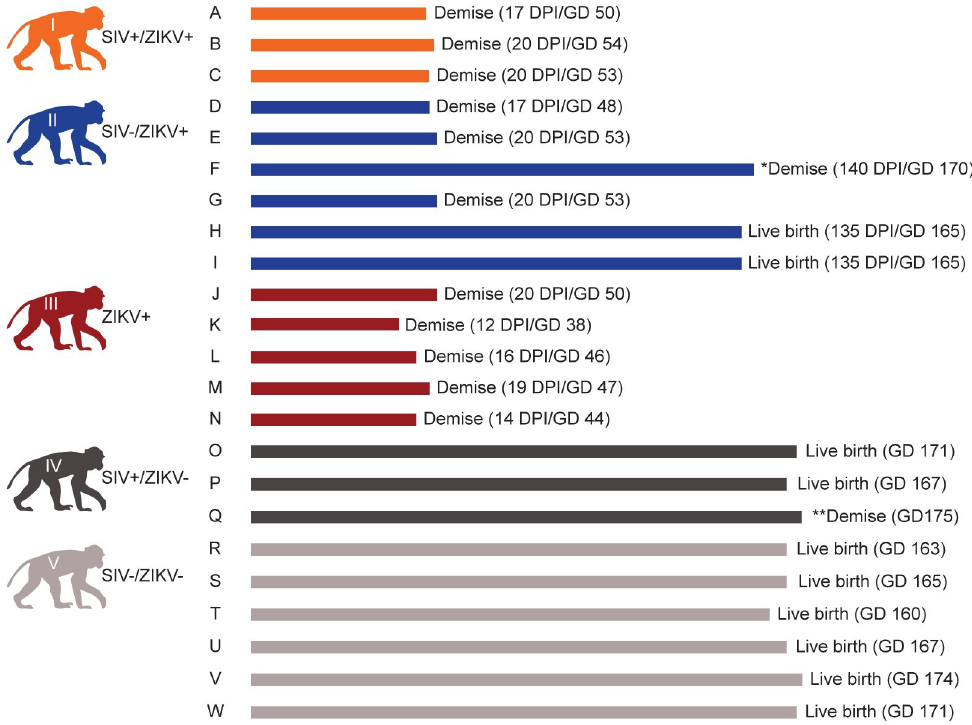
Fig 3. Pregnancy outcomes. * Animal F and fetus died on the day of clinical C-section (GD 170) due to anesthesia complications. ** The fetus of Animal Q died 5 days post-due date (GD 175). Macaque silhouettes were prepared by L. Raasch and are not restricted by